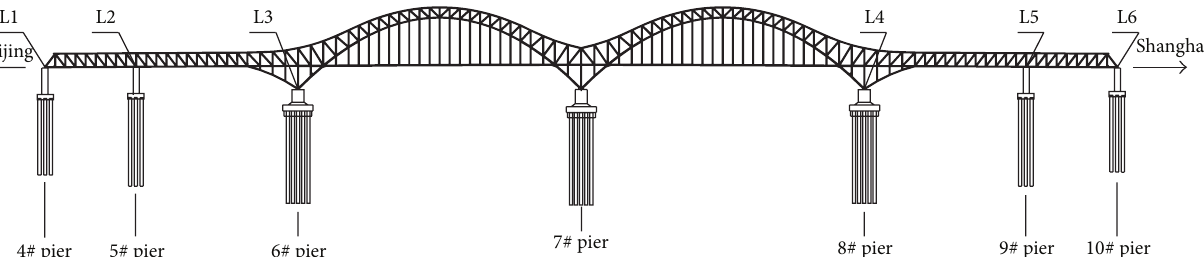
Figure 5: Layout of displacement transducers on the pier.